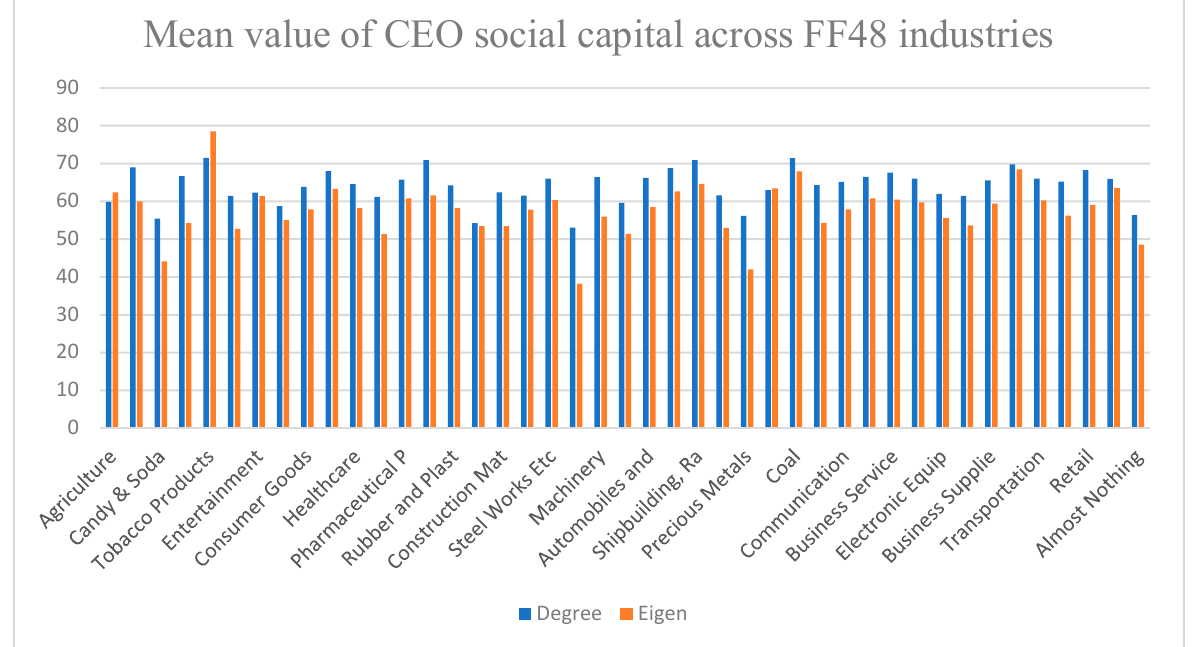
Figure 3. Mean value of CEO social capital by industries classi fi ed by Fama and French (1997).